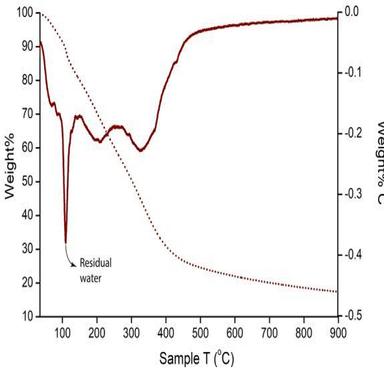
TGA (dashed) and dTGA curves for the PL used in this study.